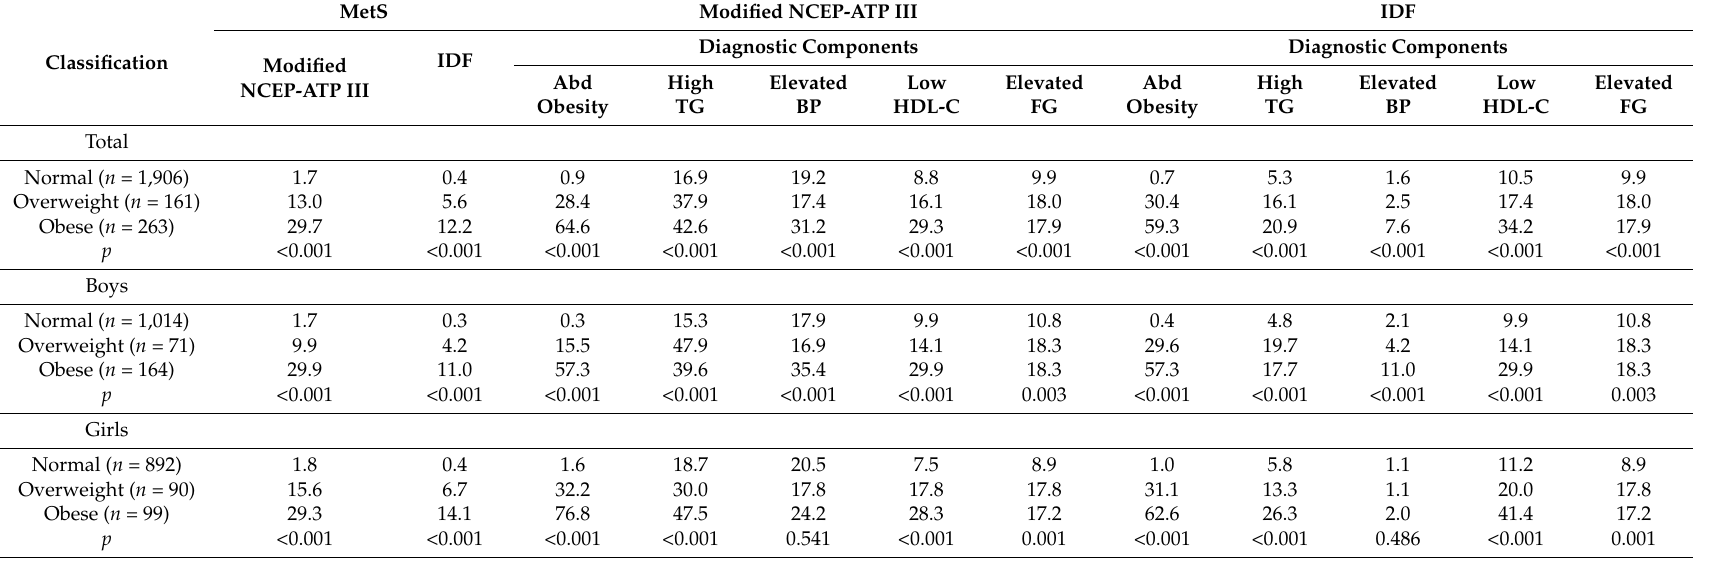
Table 4. Distributions of metabolic syndrome and diagnostic component frequencies by body mass